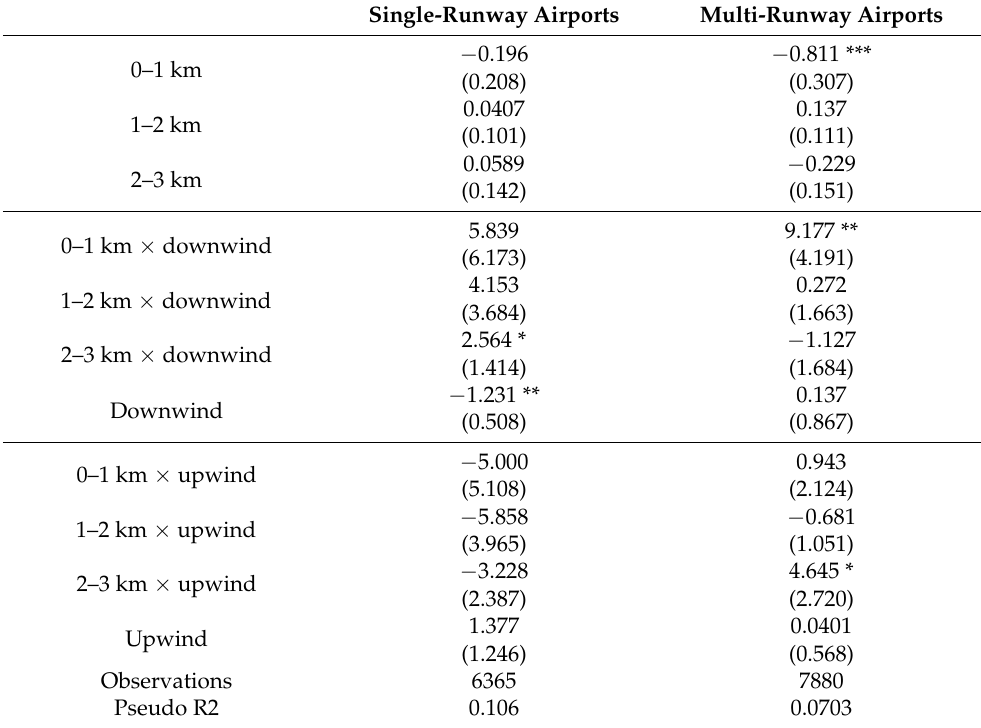
Table 5. Key coefficient results from single regression with 3 km treatment cutoff: Associations between airport proximity and wind direction and age 65+ cardiovascular mortality.